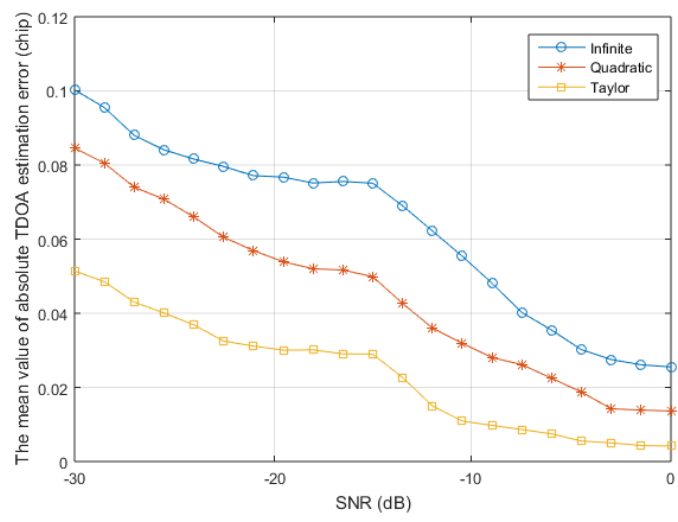
Figure 14. The TDOA estimation errors under different signal-to-noise ratio (SNR).